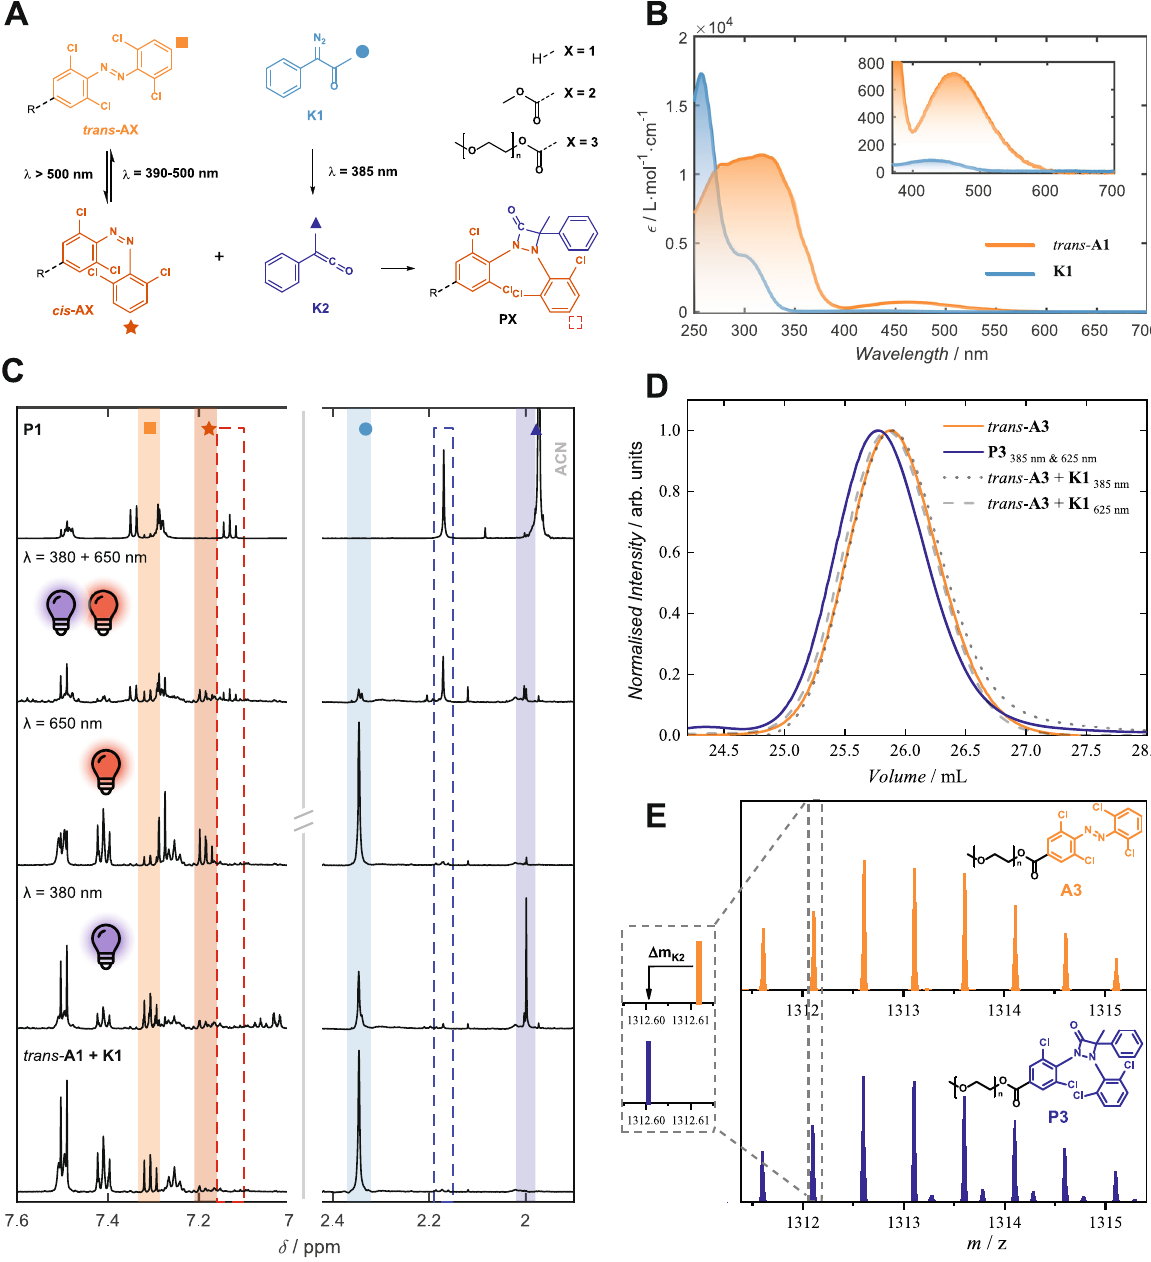
Fig. 3 Two-colour photoligation system. A Reaction scheme incorporating the ortho -substituted tetrachloride azobenzene ( A1 ), which undergoes photoisomerisation from trans to cis under orange/red light activation. Under blue light irradiation, the photoactivated ketone ( K1 ) transforms into the ketene ( K2 ) which will undergo a thermal reaction with cis - A1 to produce the ligation product P1 . B Molar extinction coef fi cients of trans - A1 and K1 showing the potential orthogonal window ~400nm. C 1 H-NMR spectra of unirradiated reaction mixture of trans - A1 and K1 (bottom), after irradiation with 650 nm only, 380 nm only and 650 nm and 380 nm, for comparison with isolated product P1 (top). D Size-exclusion chromatography of A3 and after irradiation with K1 using 385 nm and 625 nm forming P3 . Control experiments were conducted using only one wavelength, respectively. E Comparison of SEC-MS spectra of A3 with the spectra after the irradiation of A3 and K1 with 385 and 625 nm forming P3 . The isotopic pattern allows direct comparison of the weight gain upon endgroup modi fi